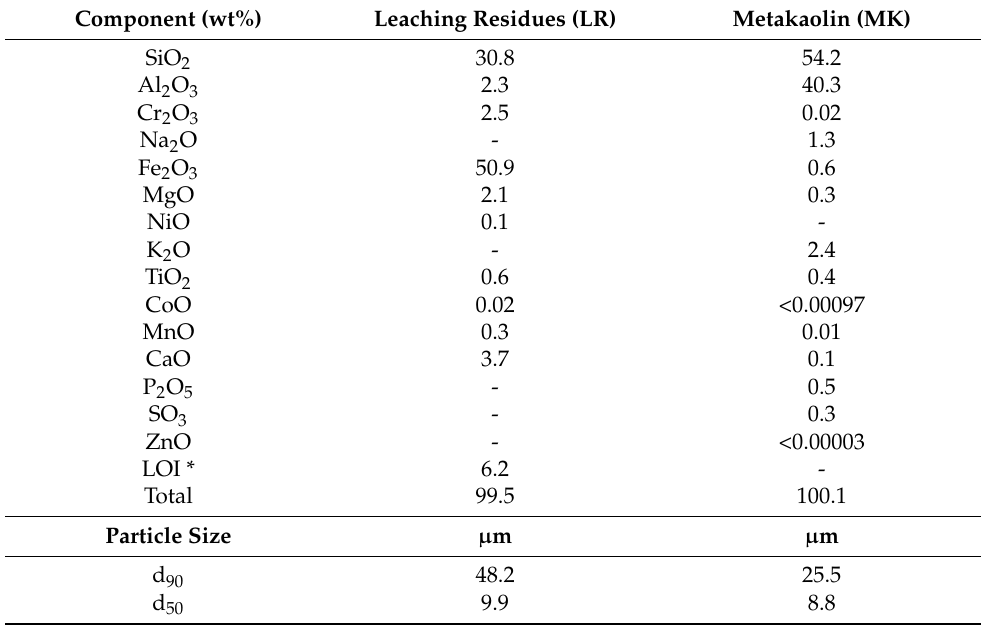
Table 1. Chemical composition (wt%) and particle size distribution of raw